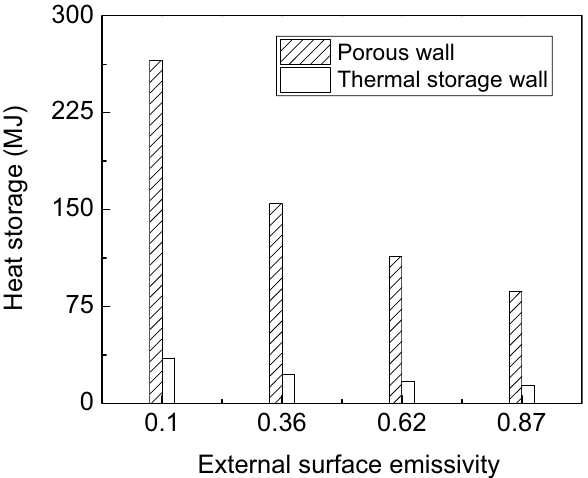
Figure 6. The influence of the external surface emissivity on the heat storage of porous wall and thermal storage wall.